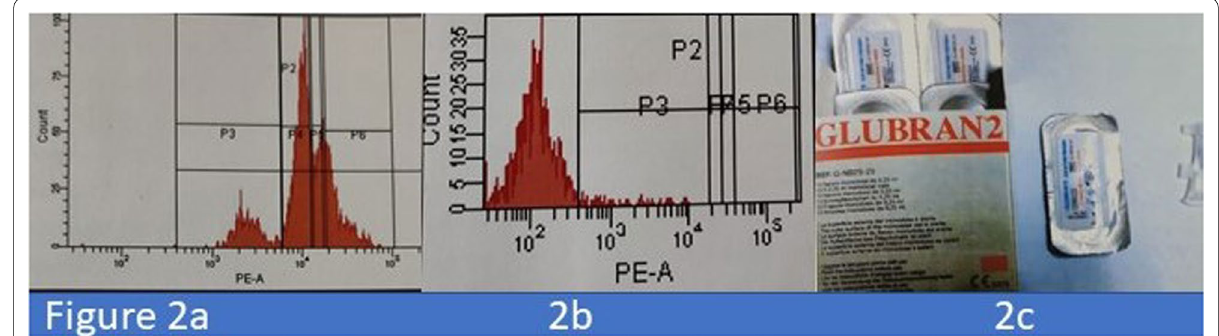
Data presented in mean standard deviation. One-way ANOVA test used between four (I, II, III, IV) groups followed by Post hoc test.; Independent samples t test used ± between Contralateral hemi testis measured at 70 day and 120 days of life. PHT *JS Johnsen Score, STD seminiferous Tubular diameter, DFC = =